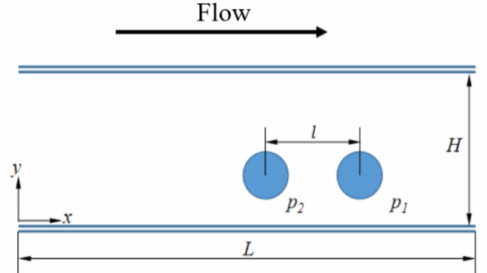
Figure 1. Schematic diagram of particle migration.